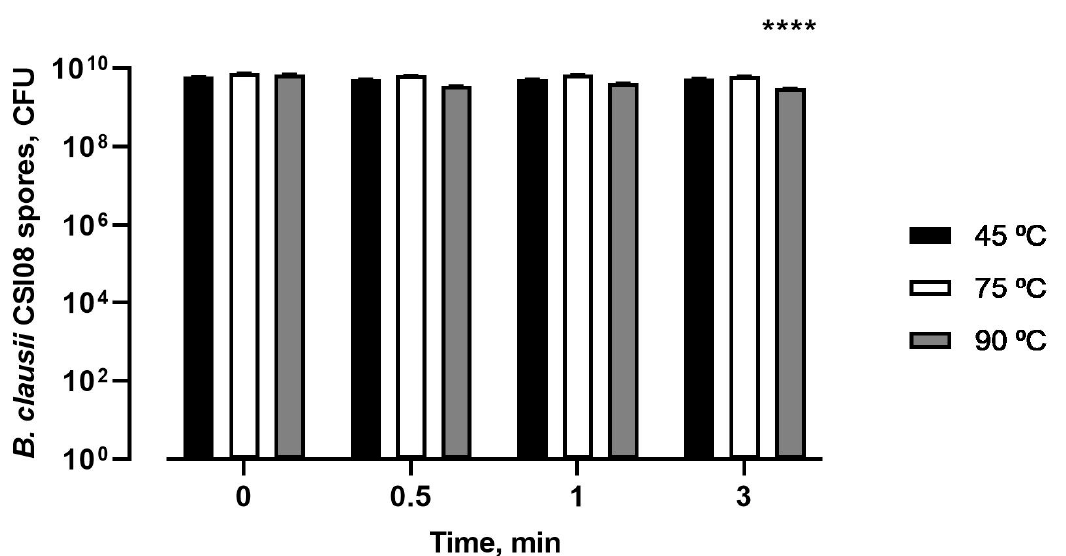
Figure 2. Thermostability of B. clausii CSI08 spores at 45, 75, and 90 °C at different time intervals. The values are expressed in CFU of spores. Data represent the mean (n = 9) ± SEM of three independent experiments performed in triplicate. Spore counts compared to 0 min. **** p < 0.0001.